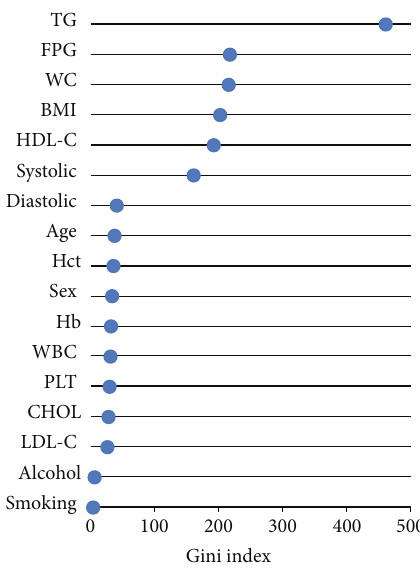
Figure 5: Health parameters importance